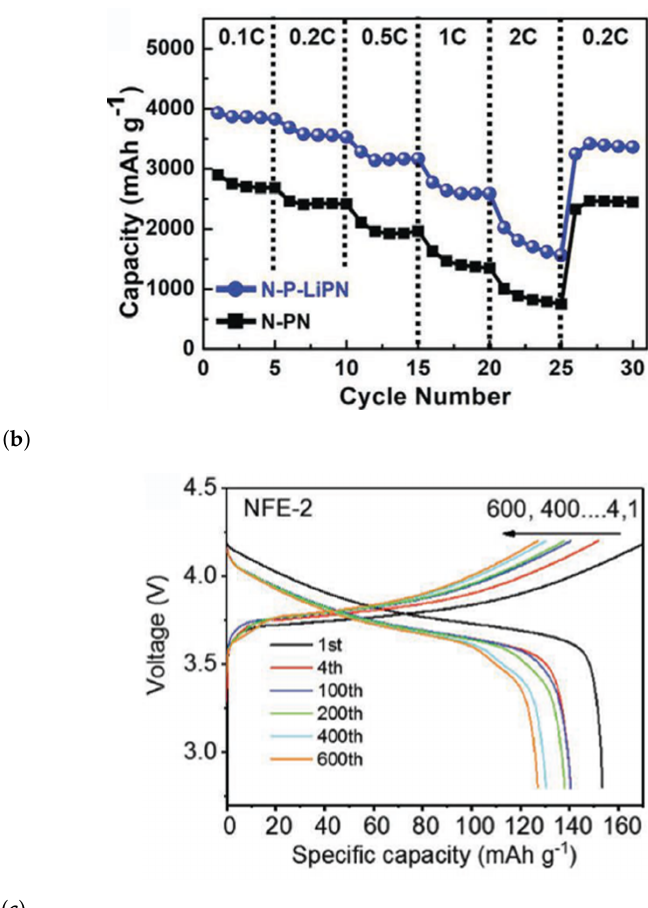
Figure 25. Si anodes enhanced by alternative techniques. ( a ) Charge/discharge curves for Si anodes binded by Polyamid films. Reproduced with permission [117]. ( b ) Charge/discharge curves, rate capability for Si anodes binded by a networked structure incorporating hard and soft LiPAA/LiPN phases. Reproduced with permission [118]. ( c ) Charge/discharge curves, and rate capability of half-cells with Si anode and high salt concentration liquid electrolyte. Reproduced with permission